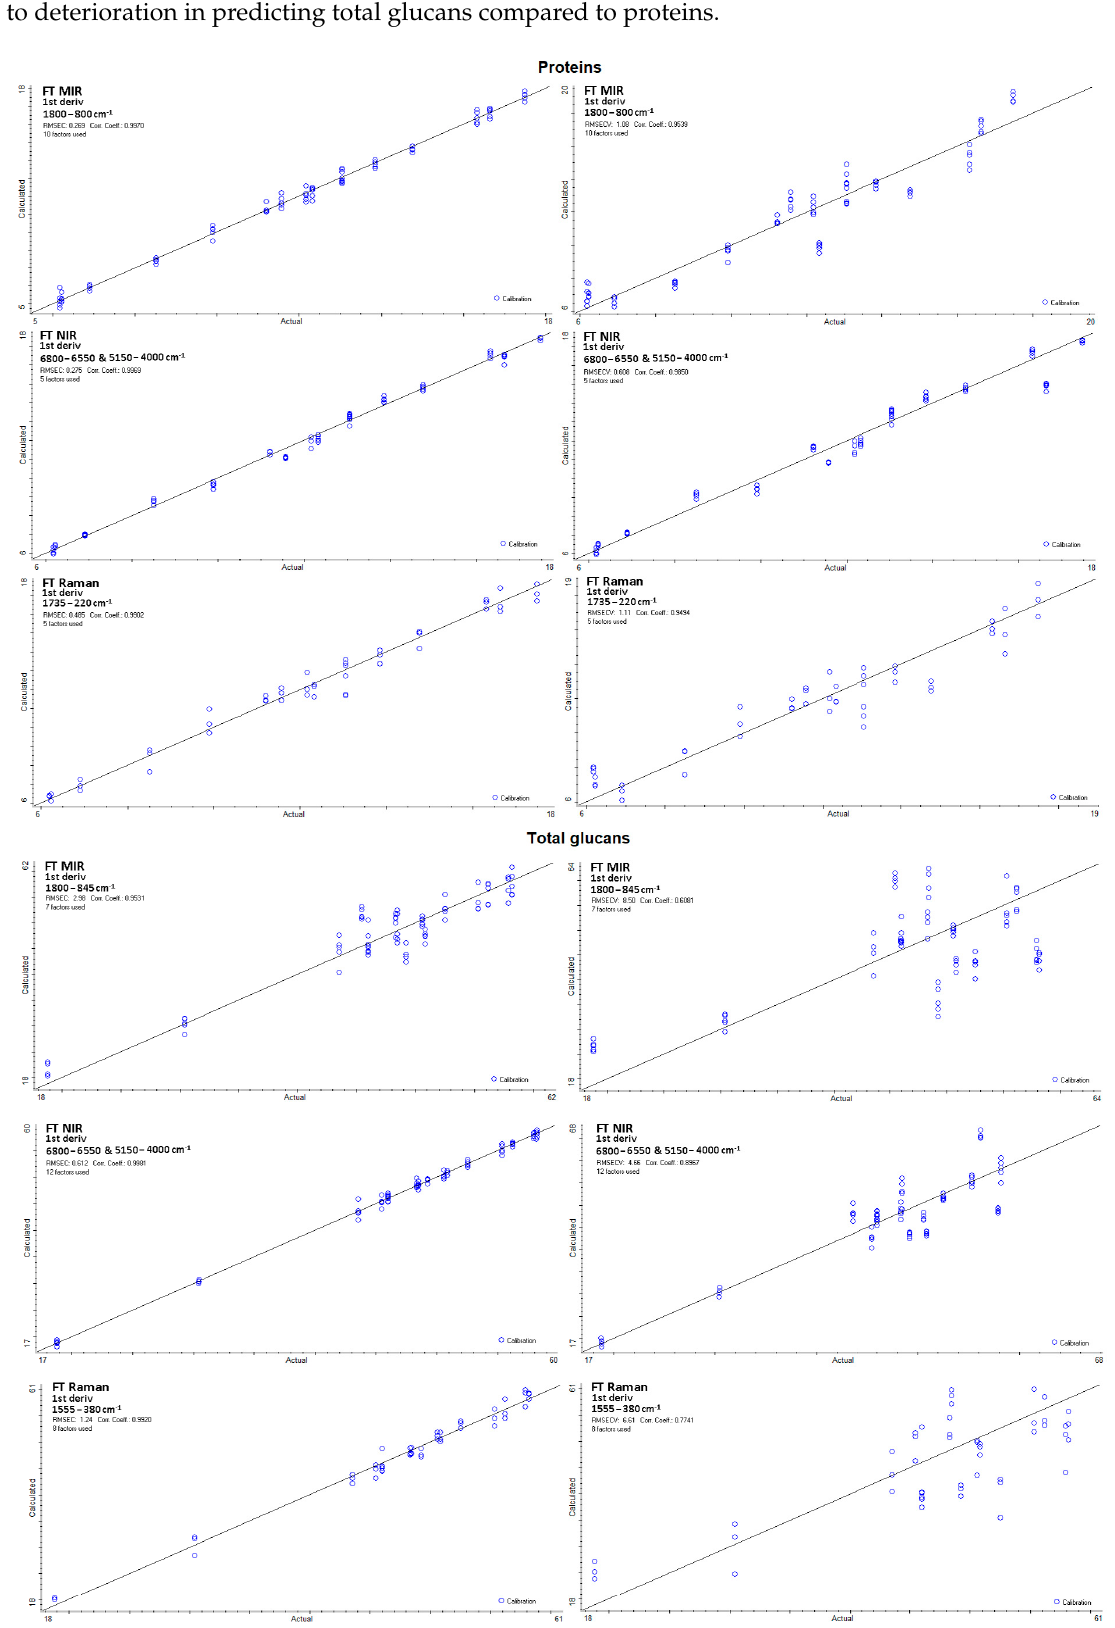
Figure 4. The PLSR models for the protein and total glucan contents in P. ostreatus